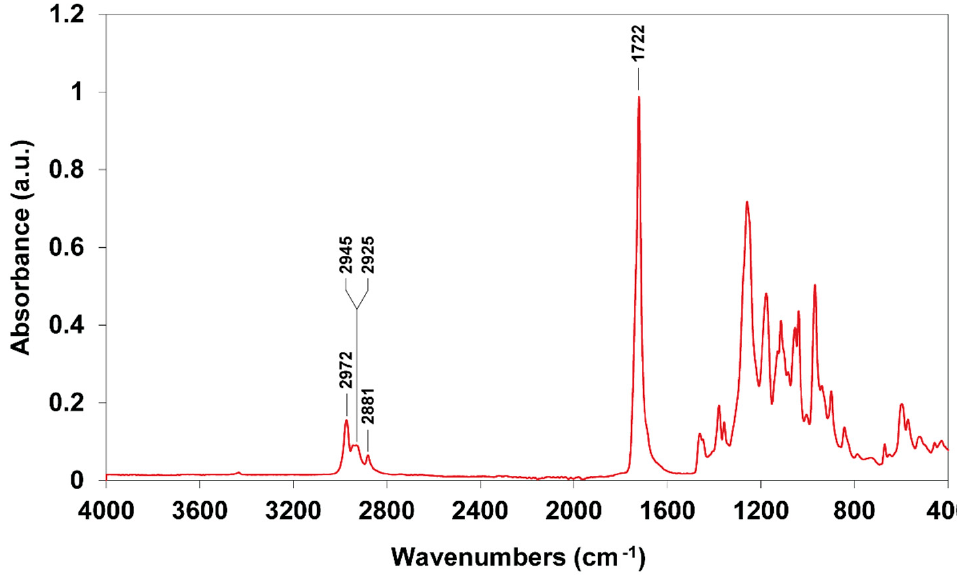
Figure 7. Fourier transform infrared spectroscopy (FTIR) spectra of PHBV extracted from Cyanosarcina sp. AARL T020.